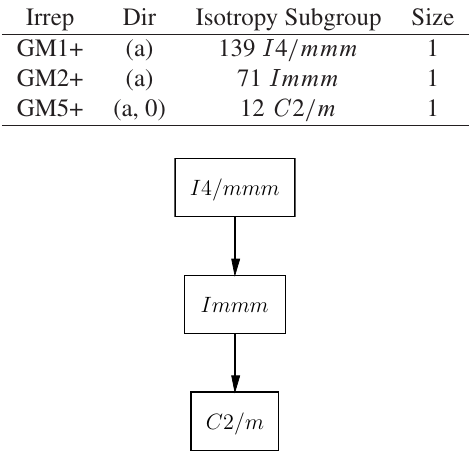
Figure 5. Graph of maximal subgroups connecting the space group I 4 /mmm and its subgroup C 2 /m ( − b − c , a , c ;000) (or equivalent), obtained with SUBGROUPGRAPH ( to obtain this graph one has to choose the correct conjugacy class among the three classes given by the program